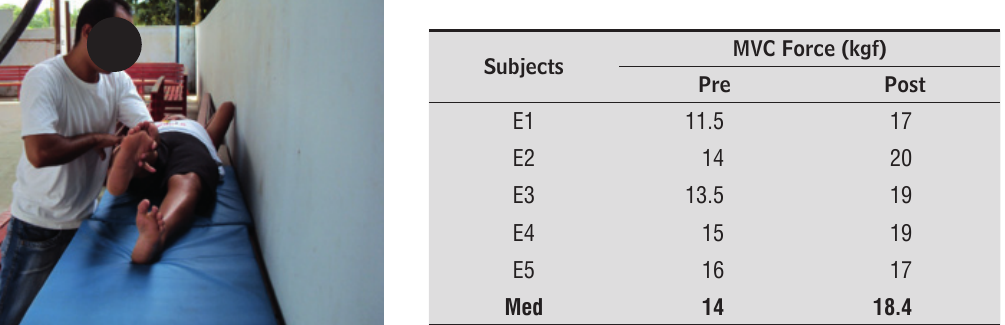
Table 2 - EG Muscle Strength before and after training